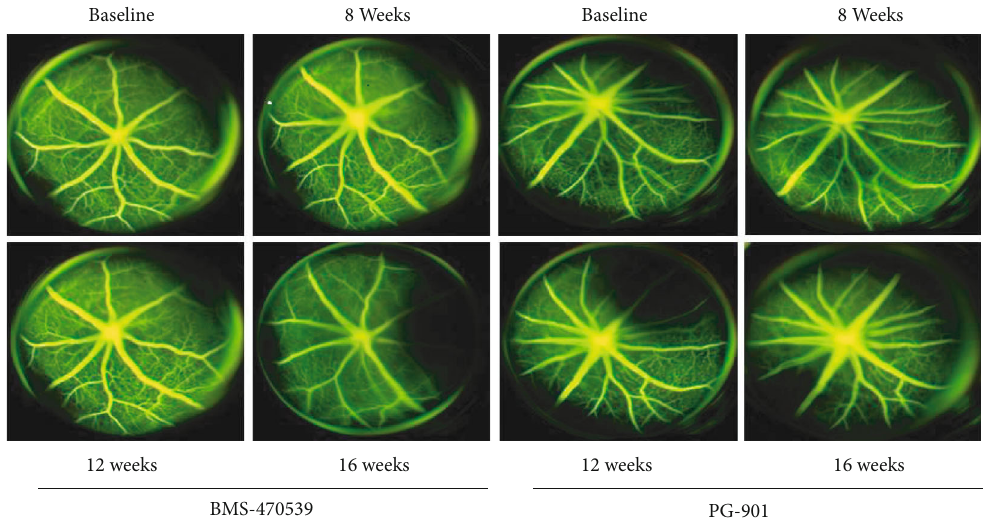
Figure 3: Representative pictures of FAG showed a regular course and caliber of retinal vessels without microvascular changes or vessel leakage at every time point following intravitreal injection of the MC1 melanocortin receptor agonist BMS-470539 and of the MC5 agonist PG-901. The number of mice for each group was n = 10 nondiabetic mice (baseline) and 8 diabetic mice with